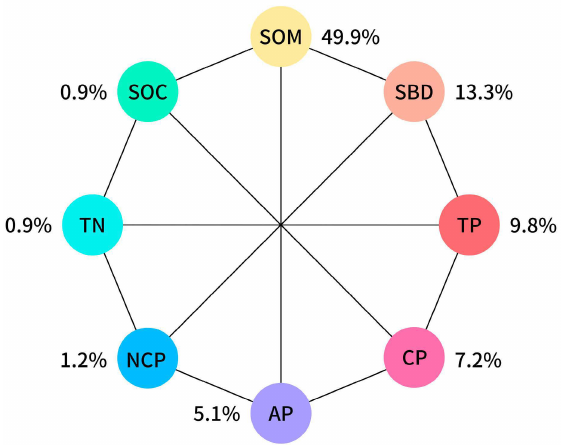
Figure 10. Variance partitioning analysis (VPA) showing the effects of soil factors on understory plant diversity in